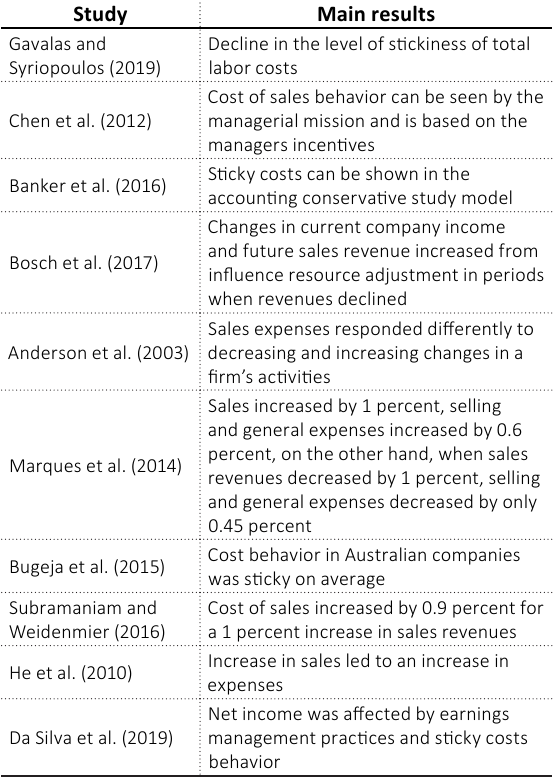
Table 1. Literature review summary Study Main